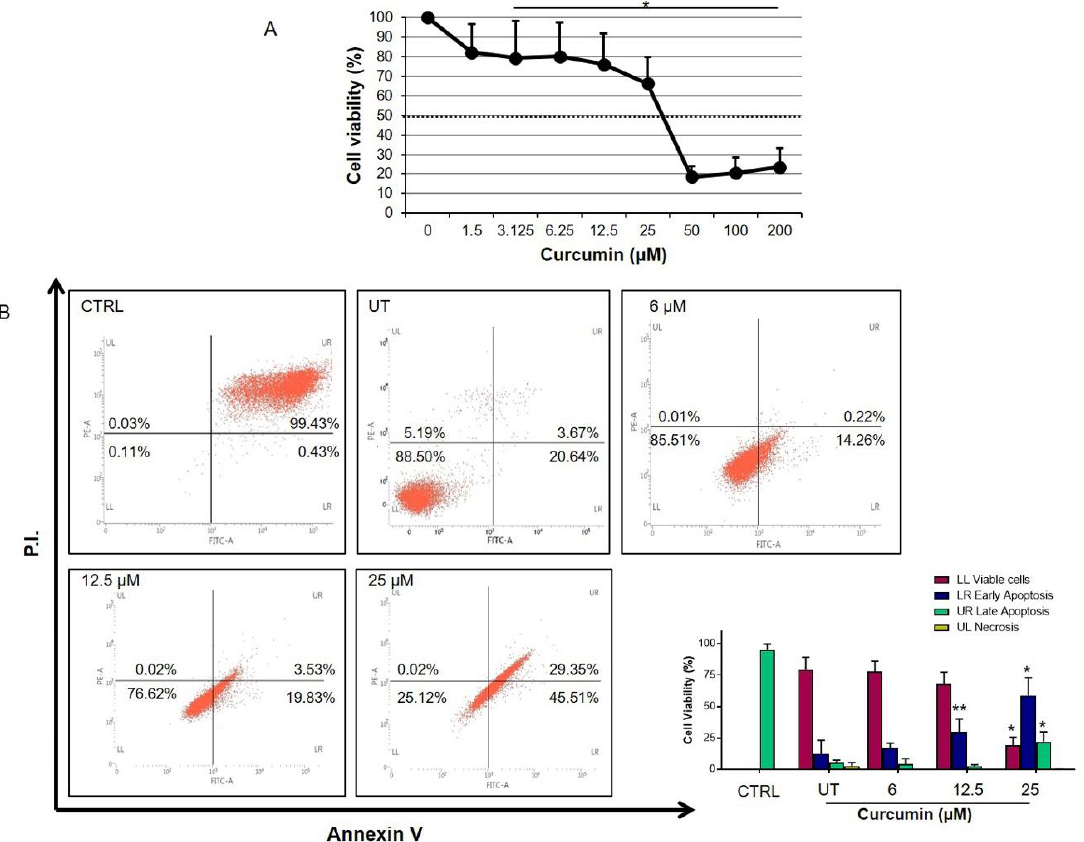
Figure 1. Effects of curcumin on cell proliferation ( A ) MTT (3-(4,5-dimethylthiazol-2-yl)-2,5- diphenyltetrazolium bromide) test analysis. LAN-5 cell viability treated with different curcumin doses (1.5–200 µM) for 24 h using MTT assay. Vertical axis percentage of cell viability; horizontal axis, the concentration of curcumin in micrometers. A dose-dependent decrease in LAN-5 cell viability was observed (growth 50% index = 37.5 μM). * p < 0.05 vs. untreated cells (UT). ( B ) Representative flow cytometry graphs are shown for control cells (CTRL, cells treated with dimethyl sulfoxide, DMSO) and for UT and treated with 6, 12.5, and 25 µM of curcumin (P.I.: propidium iodide). The histograms are representative of three independent experiments and show the effect of different doses of curcumin on LAN-5 apoptosis (* p < 0.0001 vs. UT; ** p = 0.04 vs. UT).